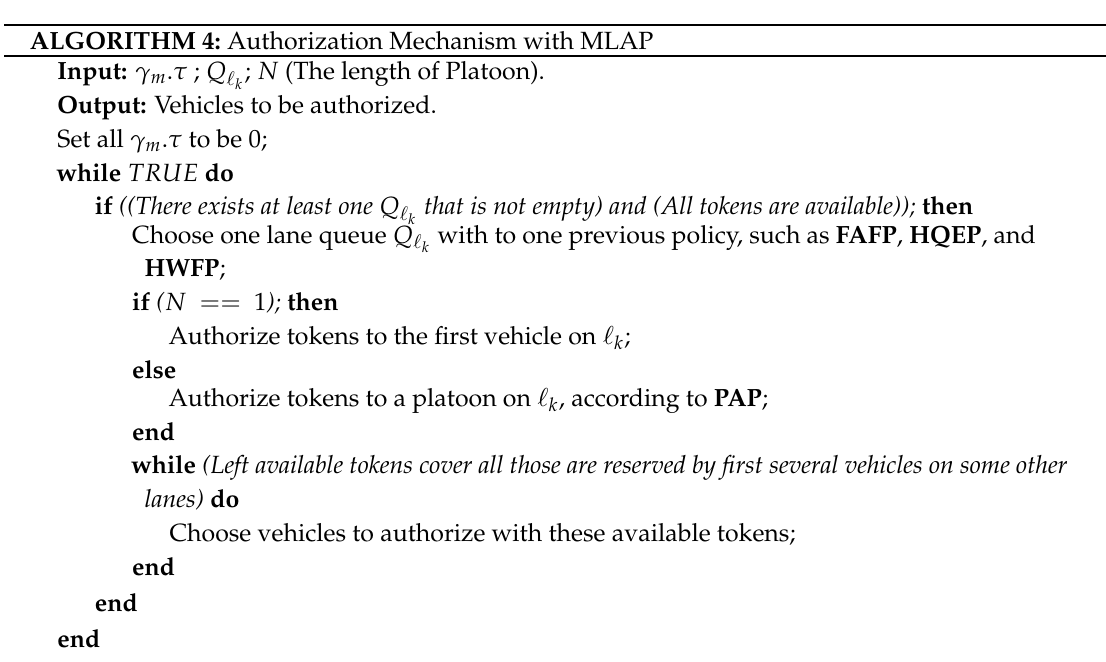
ALGORITHM 4: Authorization Mechanism with